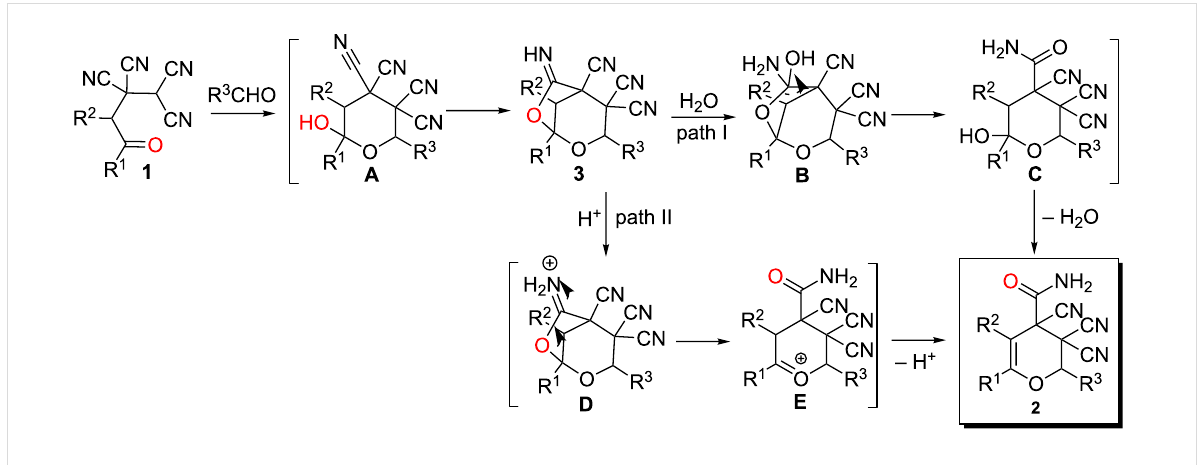
Scheme 3: Plausible reaction pathways for 3,4-dihydro-2 H -pyran-4-carbxamides 2